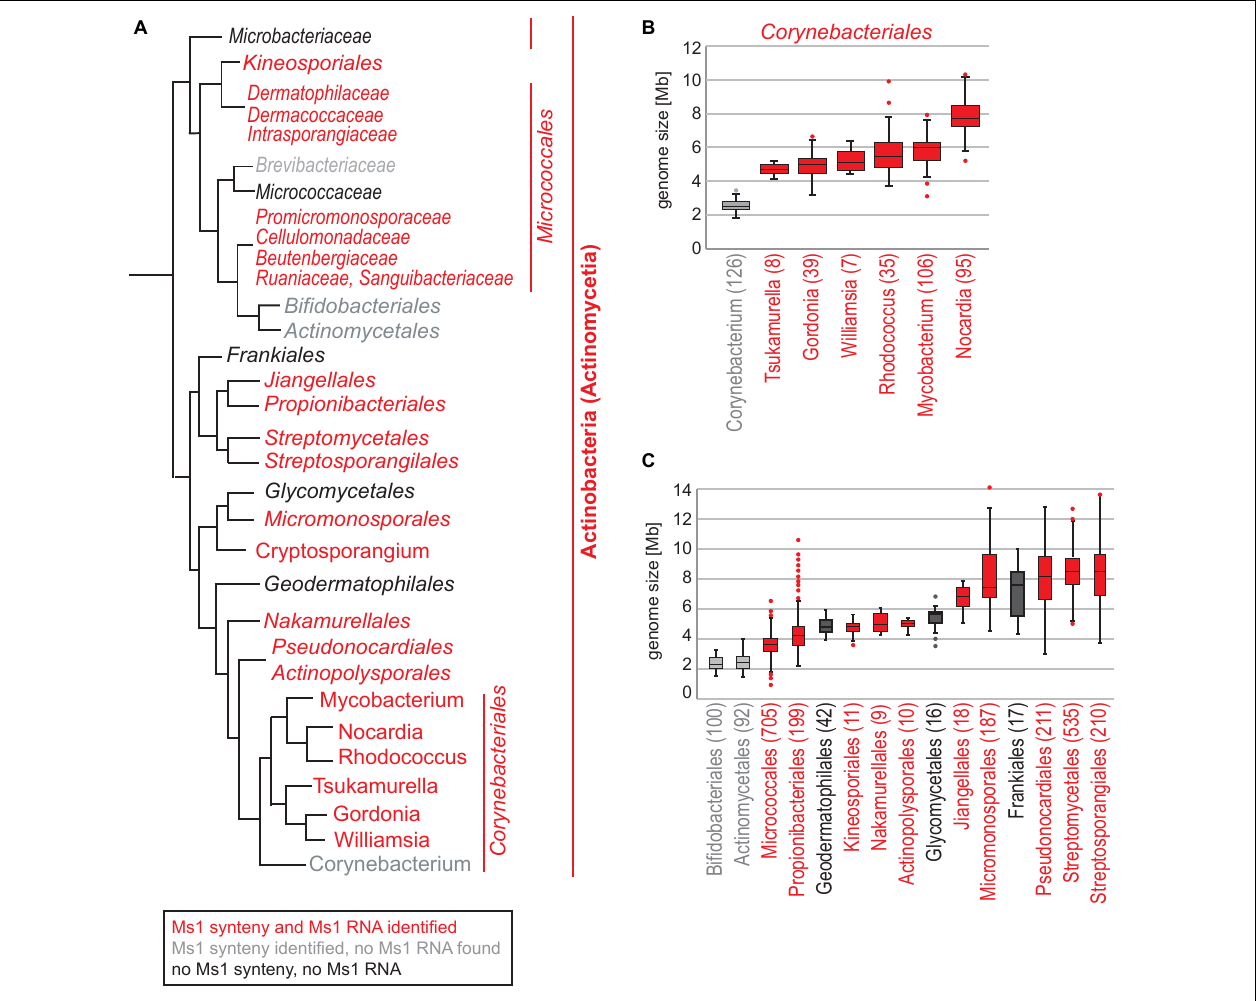
FIGURE 6 | (A) Ms1 homologs were identified in Actinobacteria orders (in italics) or families (narrow italics) labeled by red. Actinobacteria groups with no identified Ms1 homologs and Ms1 flanking genes are in black, groups with identified Ms1 flanking genes but no Ms1 homologs in grey. The tree was adopted from Nouioui et al. (2018). (B) Genome sizes of the Corynebacteriales and (C) Actinobacteria. Only NCBI reference genomes are shown, number of genomes is indicated in brackets.